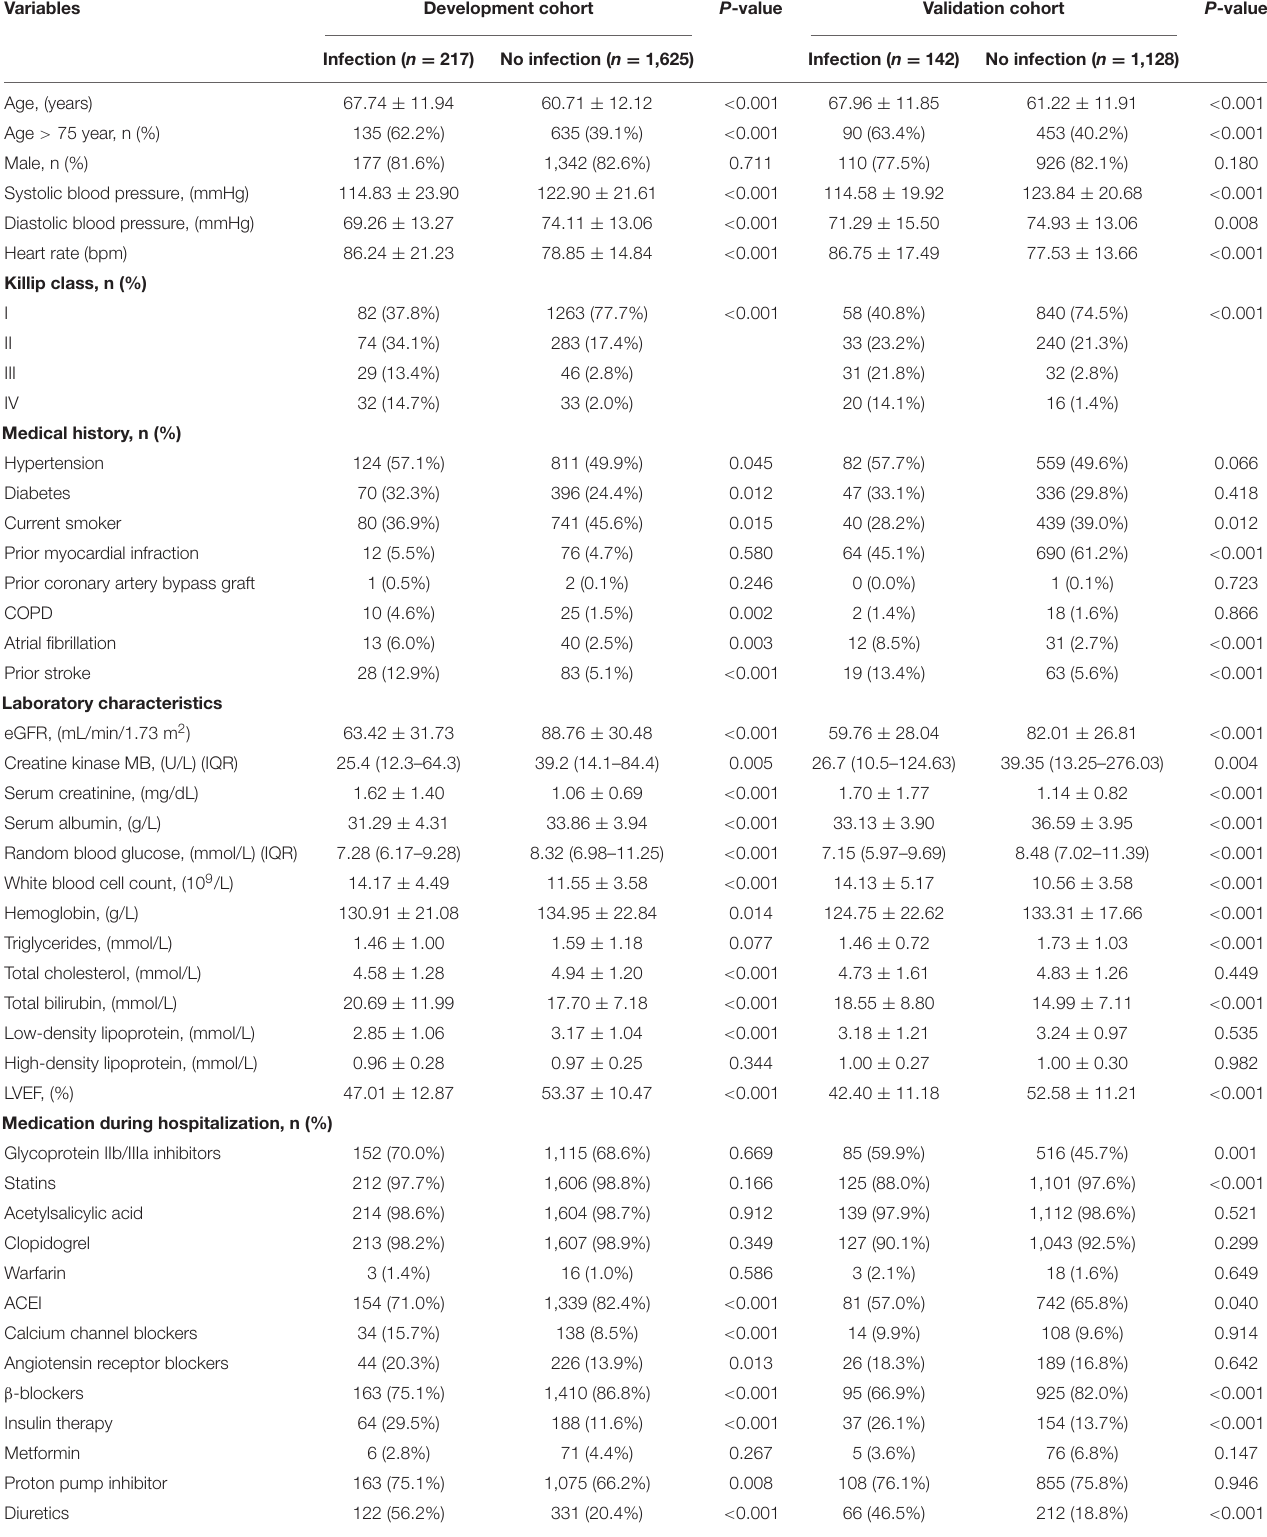
TABLE 1 | Baseline characteristics of included patients in the development cohort and validation cohort.